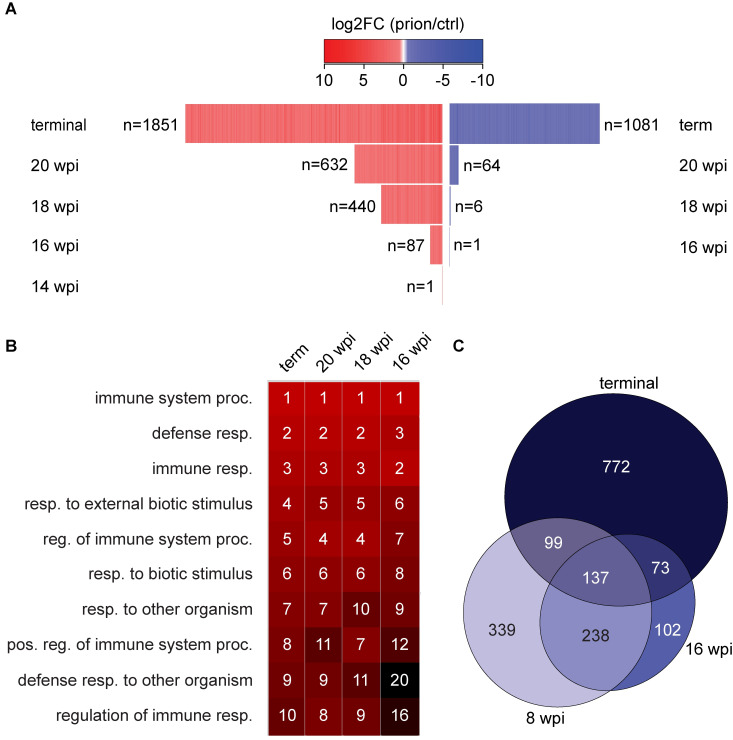
Consistent mRNA expression changes become evident in the early disease phase.A Heatmap displaying the log2FC of monotonic DEGs (mDEGs), defined as genes changing with a similar trend (|log2FC| > 0.5 and p < 0.05) at consecutive time points until terminal disease. n: number of mDEGs at each time point. B Heatmap displaying the top 10 GO terms enriched among terminally upregulated genes and their enrichment in mDEGs at 20, 18 and 16 wpi. Number and colors represent the ranking (high = red, black = low) of the respective GO terms. C Overlap of downregulated genes at 8 wpi, 16 wpi and at the terminal stage.